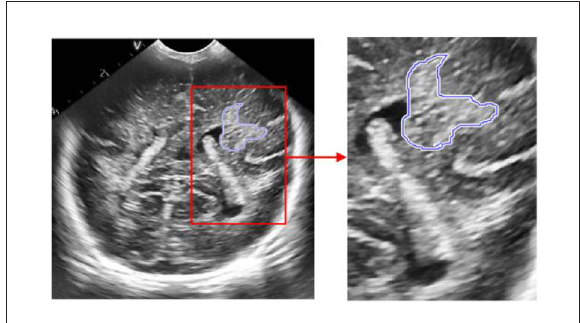
FIGURE4 Schematic diagram of region of interest frame selection process.